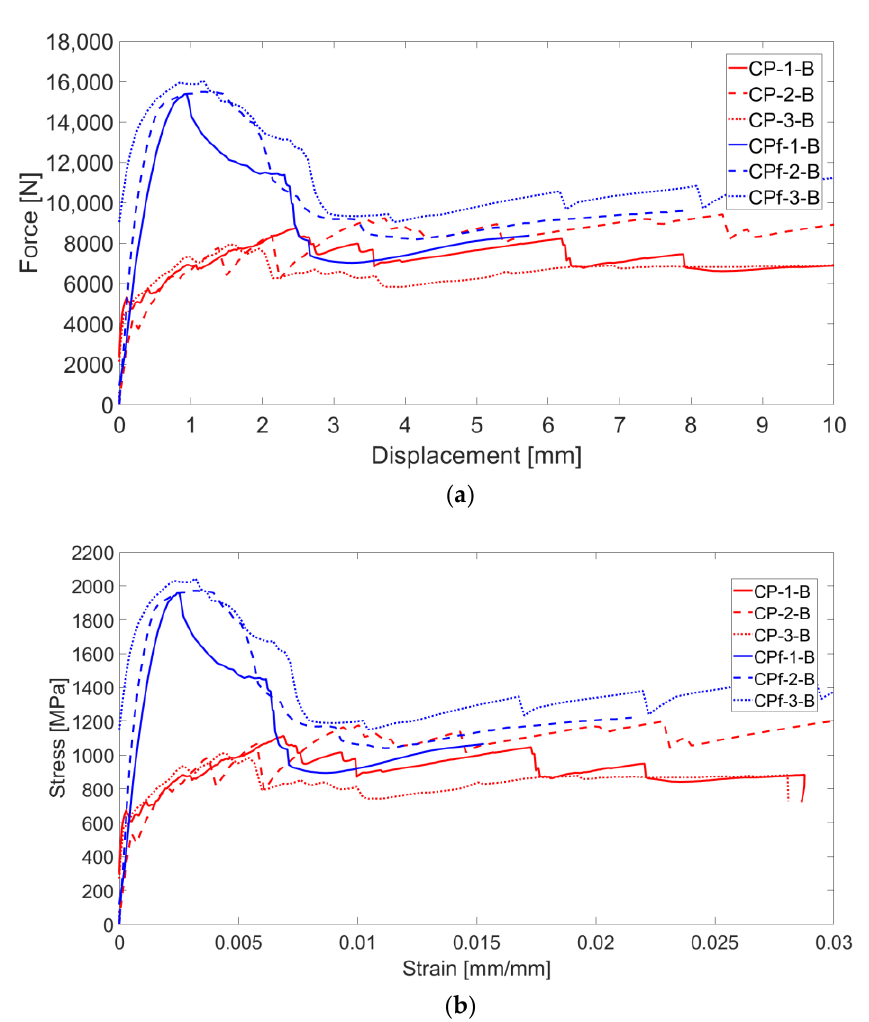
Figure 16. Force – displacement ( a ) and stress-strain ( b ) curves of C-TRC specimens (in red) and C-F/TRC specimens (in blue).